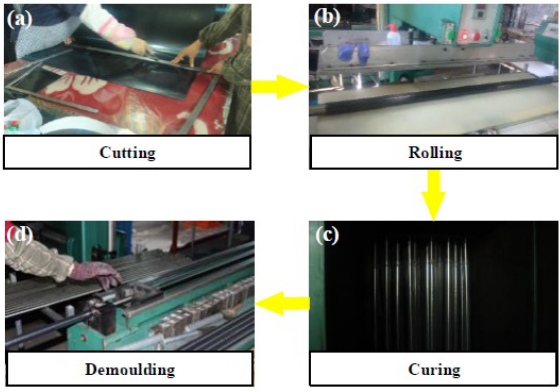
Figure 1: Manufacturing process of laminated CFRP tubes